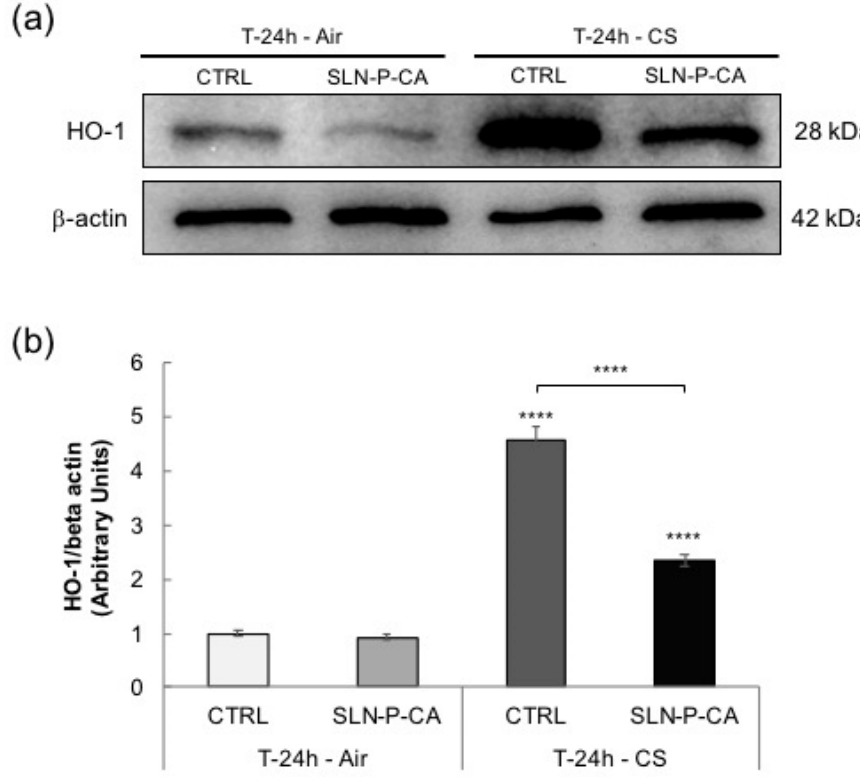
Figure 10. Expression of heme-oxygenase (HO-1) protein levels on HSE exposed to air or CS for 30 min and pre-treated with SLN-P-CA. Samples were collected after 24 h from exposure. Western blot analysis of HO-1 protein expression is representative of three experiments and β -actin was considered as control (panel a). Quantification of HO-1 expression bands as a ratio of β -actin (panel b). **** p ≤ 0.0001 with respect to control (CTRL)